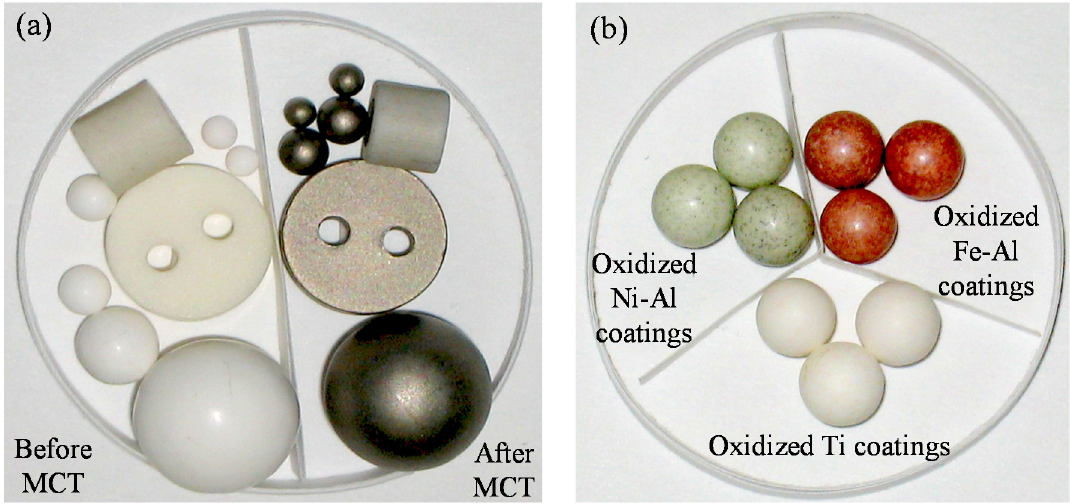
Figure 2. Appearance of samples by MCT and oxidized metal coatings. ( a ) Al 2 O 3 objects before and after MCT; ( b ) The oxidized metal